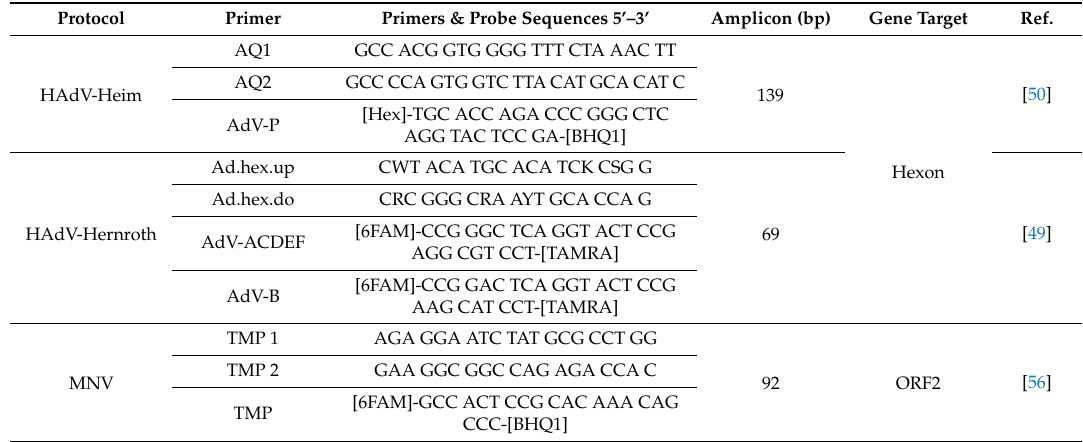
Table 1. Primer and probe sets used for qPCR detection of human adenoviruses (HAdV) and murine norovirus (MNV). Wobble bases: W = A / T; R = A / G; Y = C / T; K = G / T; and S = C /